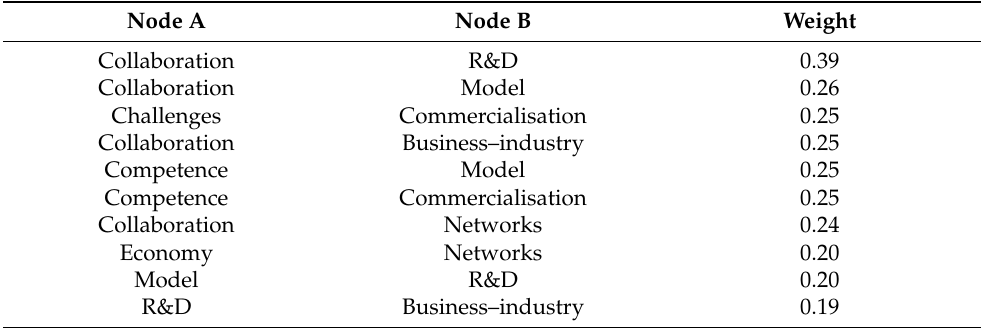
Figure 5. Evolution of the themes period 2005–2012 and thematic network of the cluster COLLABORATION. Source: Prepared by the authors on the basis of SciMAT data. Table 5. Thematic network collaboration, 2005–2012. Ten relationships with more weight.